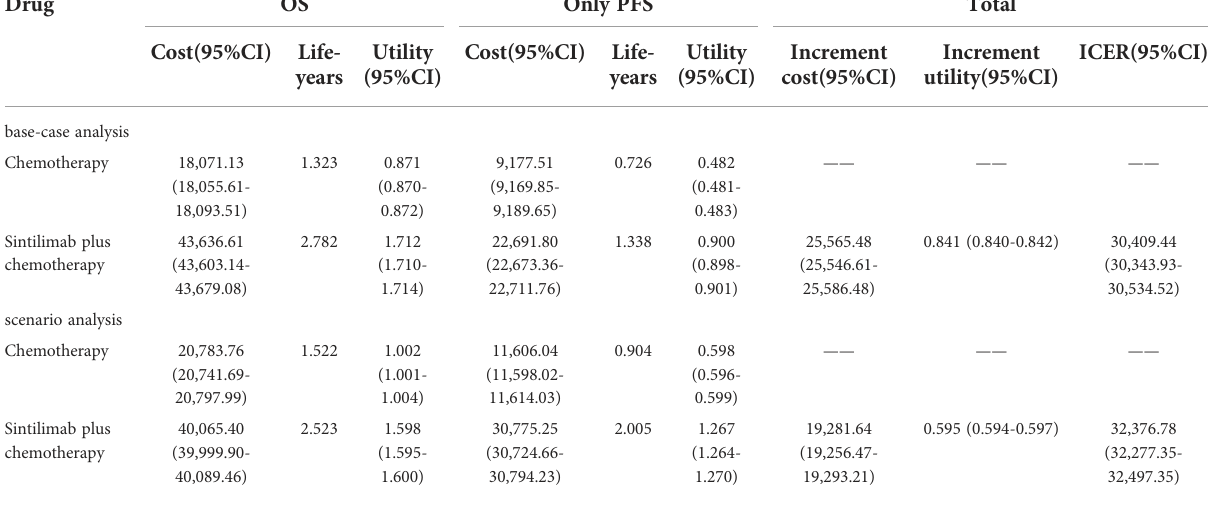
TABLE 2 Results of base-case analysis and scenario analysis.